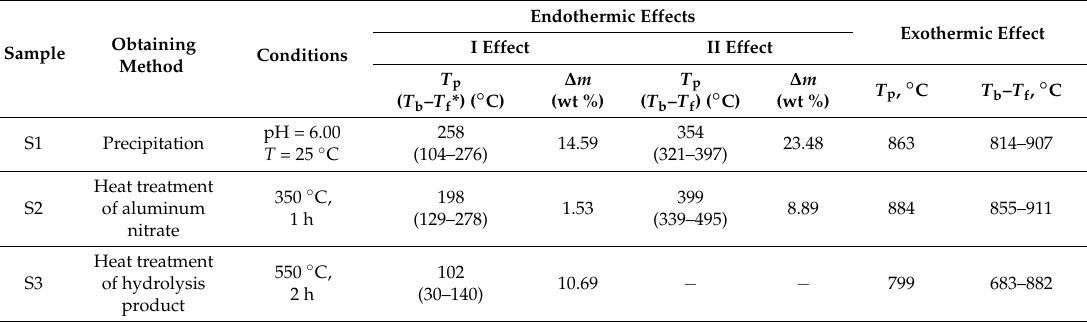
Table 2. TG-DSC and mass spectrometry (MS) analyses results of samples S1-S3.